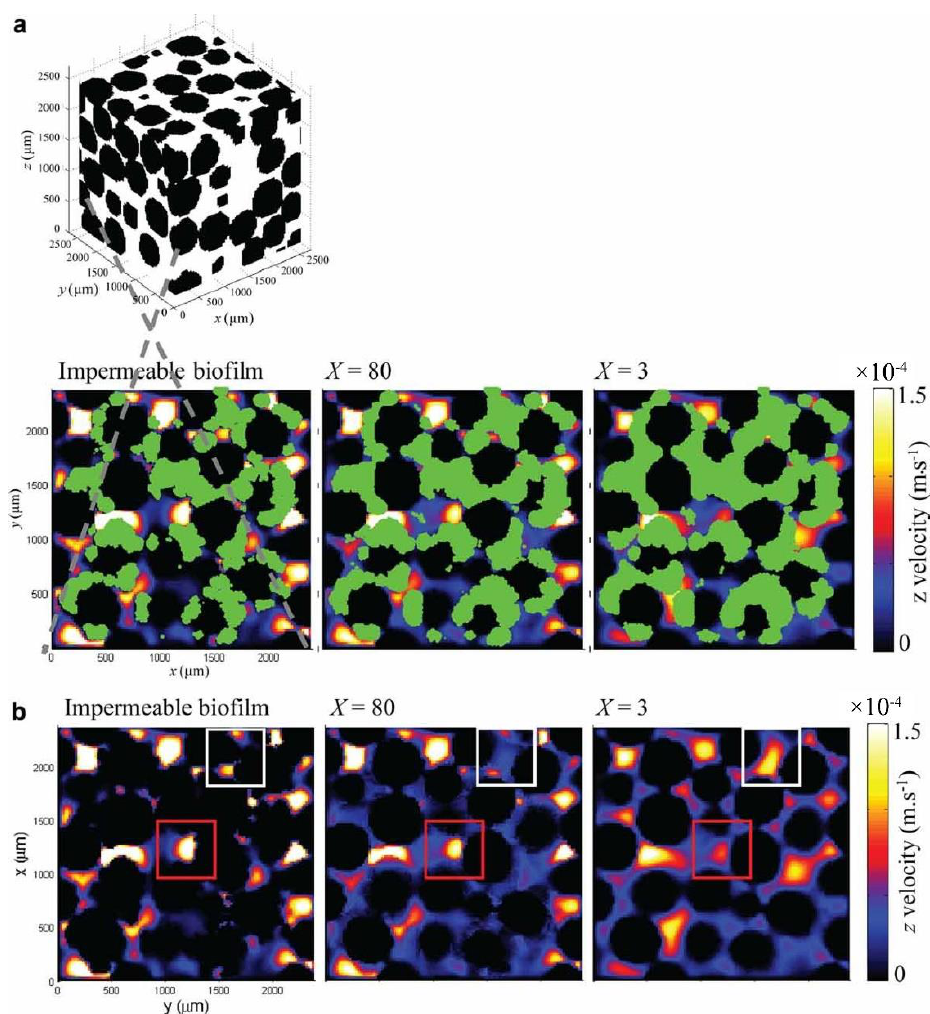
Figure 7. After 27 h development of biomass, velocity maps at slice z = 600 μm for impermeable biofilms (X = ∞) and permeable biofilms (X = 80 and X = 3) are shown in ( a ) with biomass (green areas) and ( b ) biomass omitted, (reproduced with permission from [105], Copyright John Wiley and Sons, 2012).